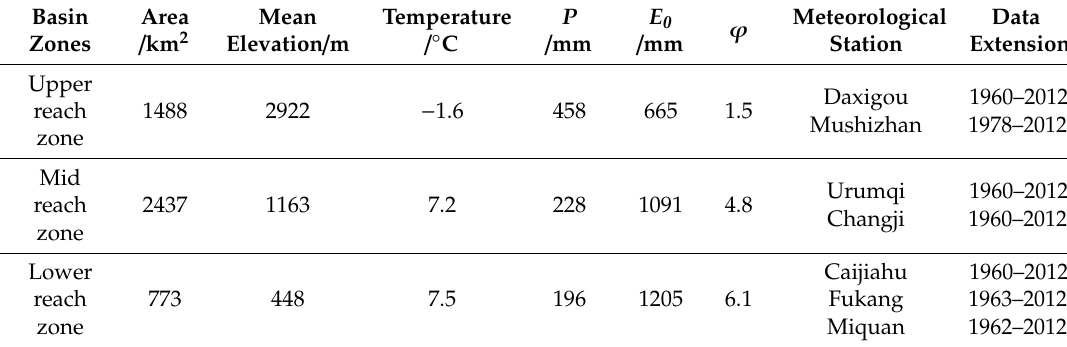
Table 1. Hydrometeorological characteristics of the Urumqi River